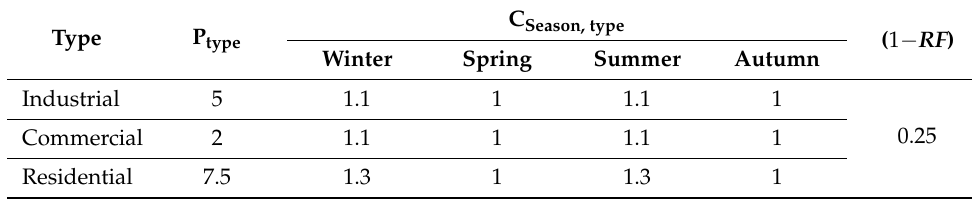
Table 1. Demand model